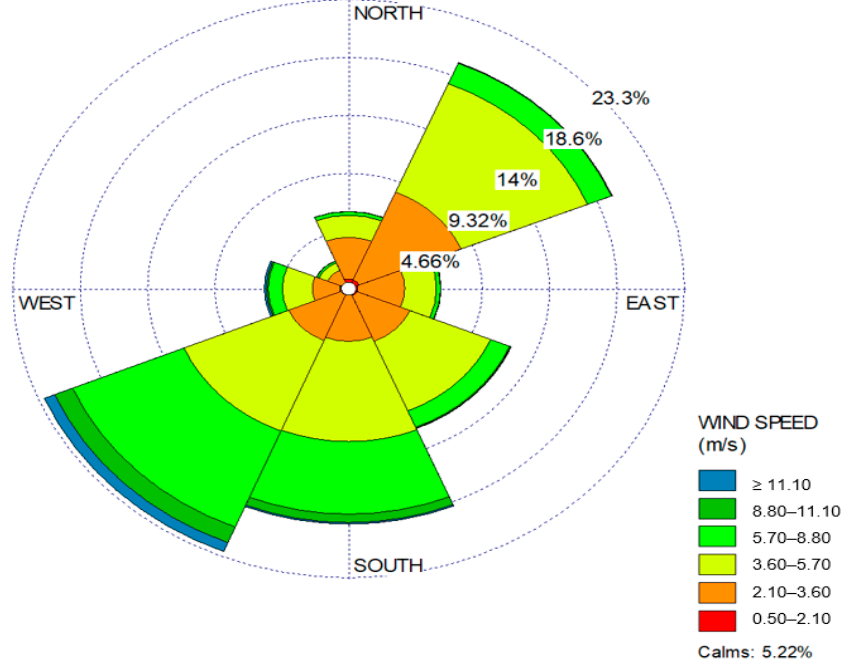
Figure 5. Wind rose plot for the Mitrovica region processed in the WRPLOT supporting program for AERMOD.